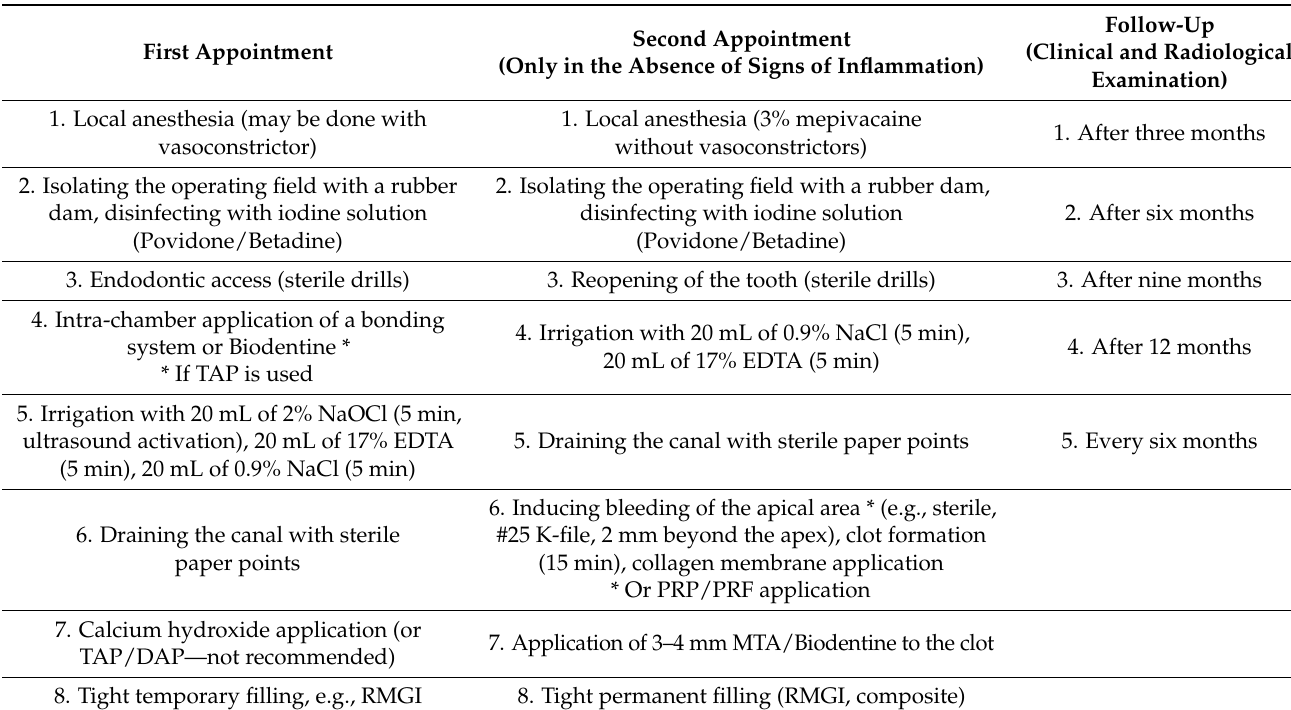
Table 5. REP—proposed